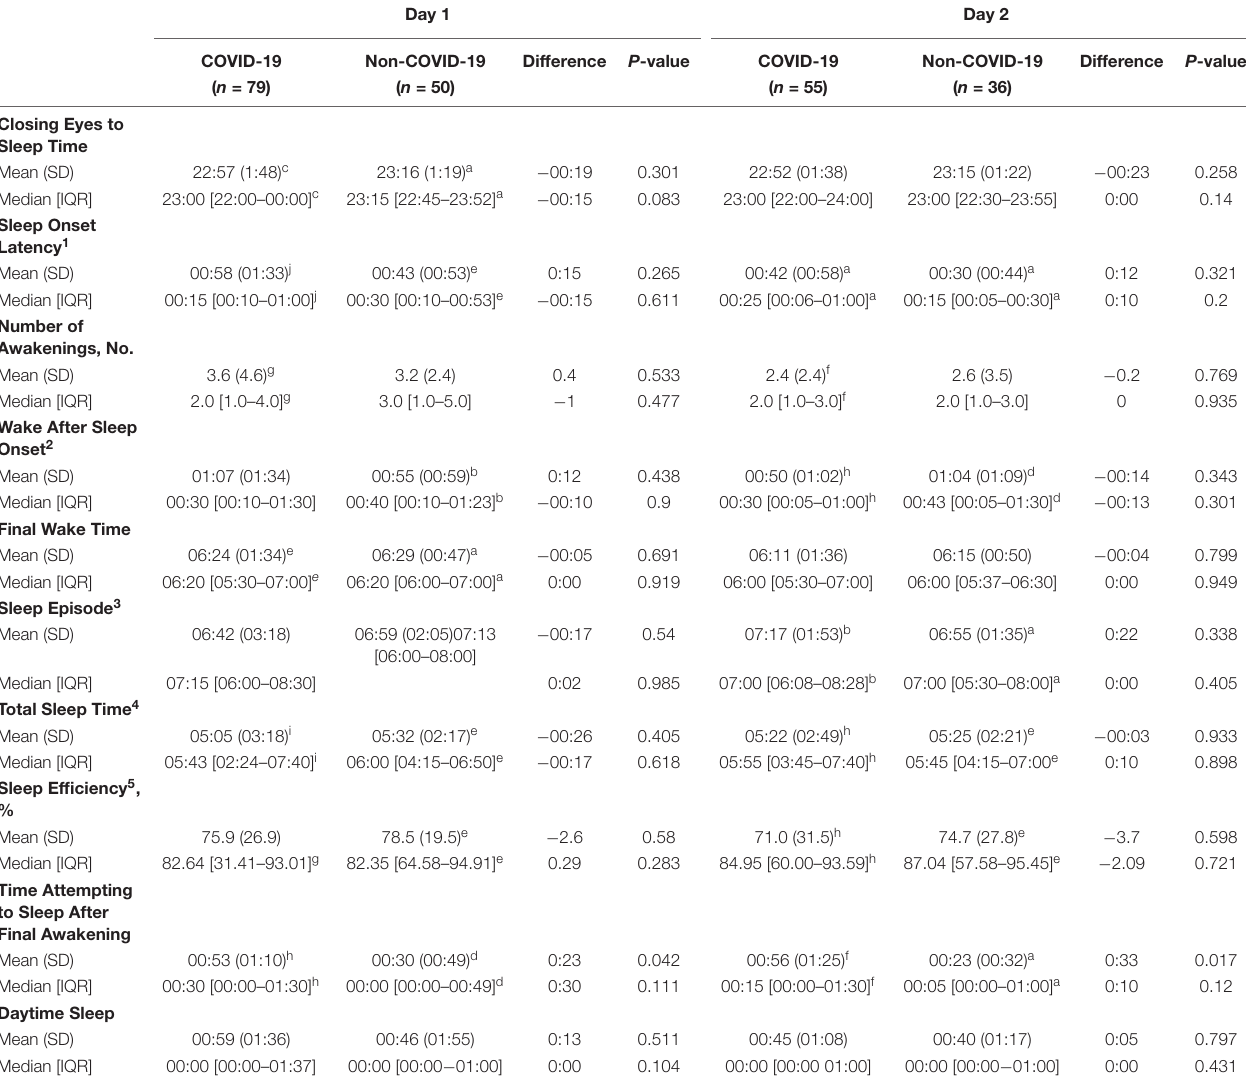
TABLE 2 | Sleep quantity by means of the Consensus Sleep